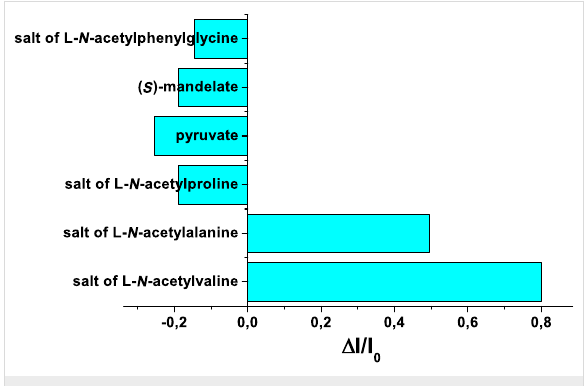
Figure 3: Change in fluorescence ratio of 1 upon addition of one equivalent of anions ( c = 4.31 × 10 − 5 M) at 492 nm.